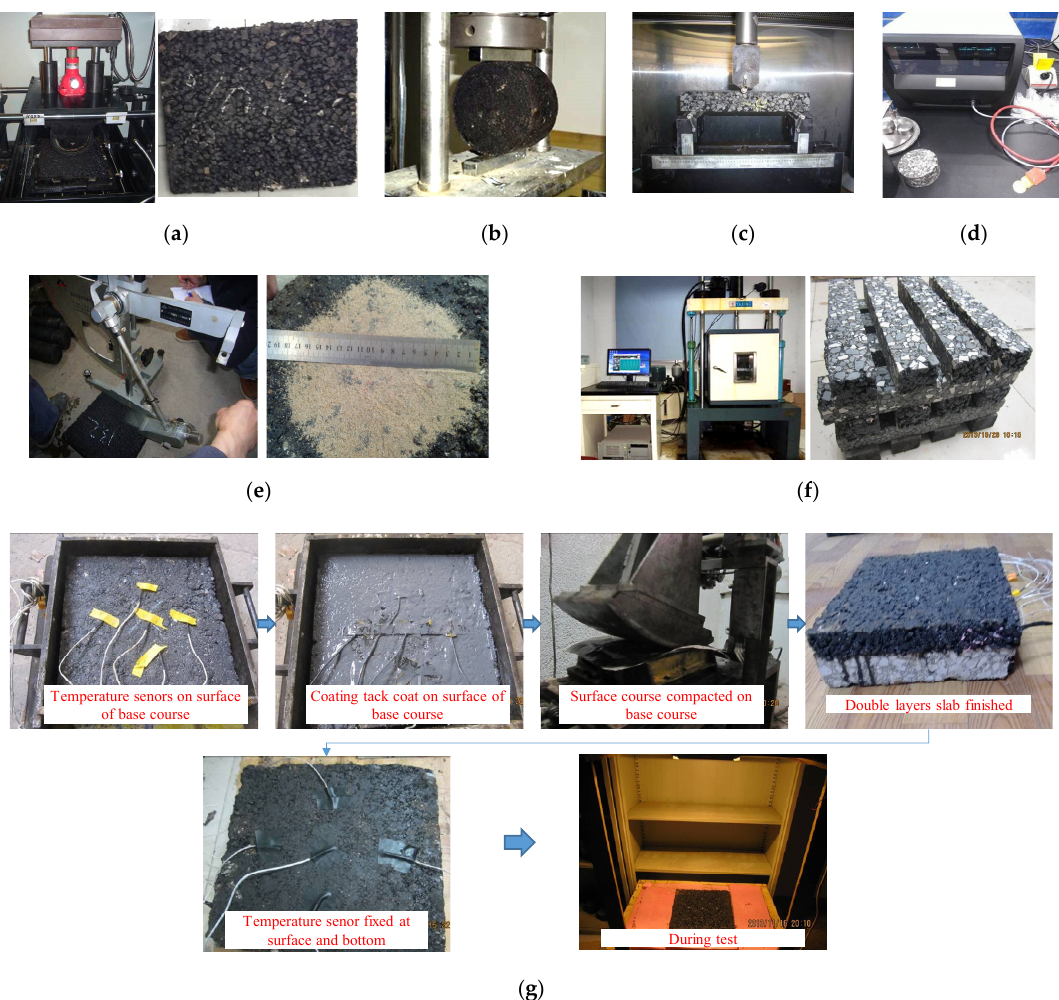
Figure 4. Test methods: ( a ) Wheel rutting test; ( b ) Freeze-thaw indirect tensile test; ( c ) Bending beam test; ( d ) HDM test; ( e ) Anti-skid performance test; ( f ) Fatigue beam test; ( g ) Thermal insulation performance test.